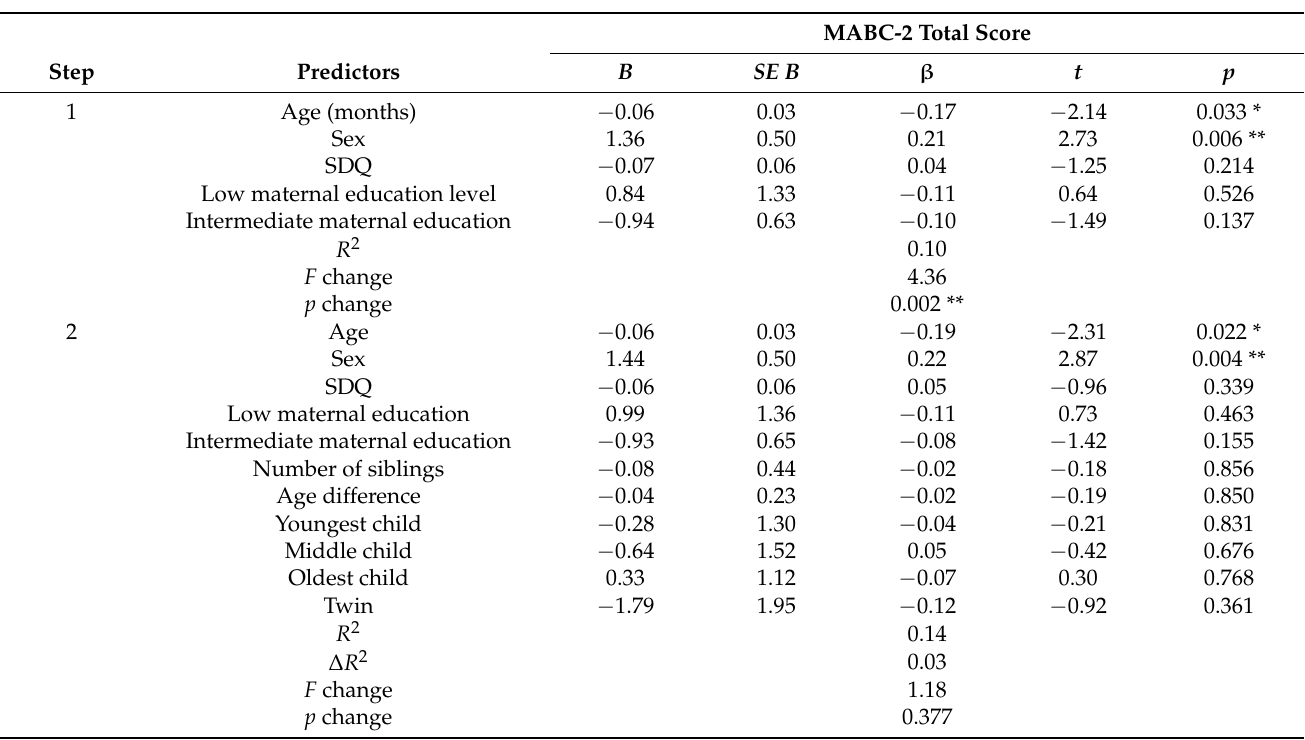
Table 3. Hierarchical multiple regression analysis predicting the MABC-2 total score from sibling variables after controlling for confounding